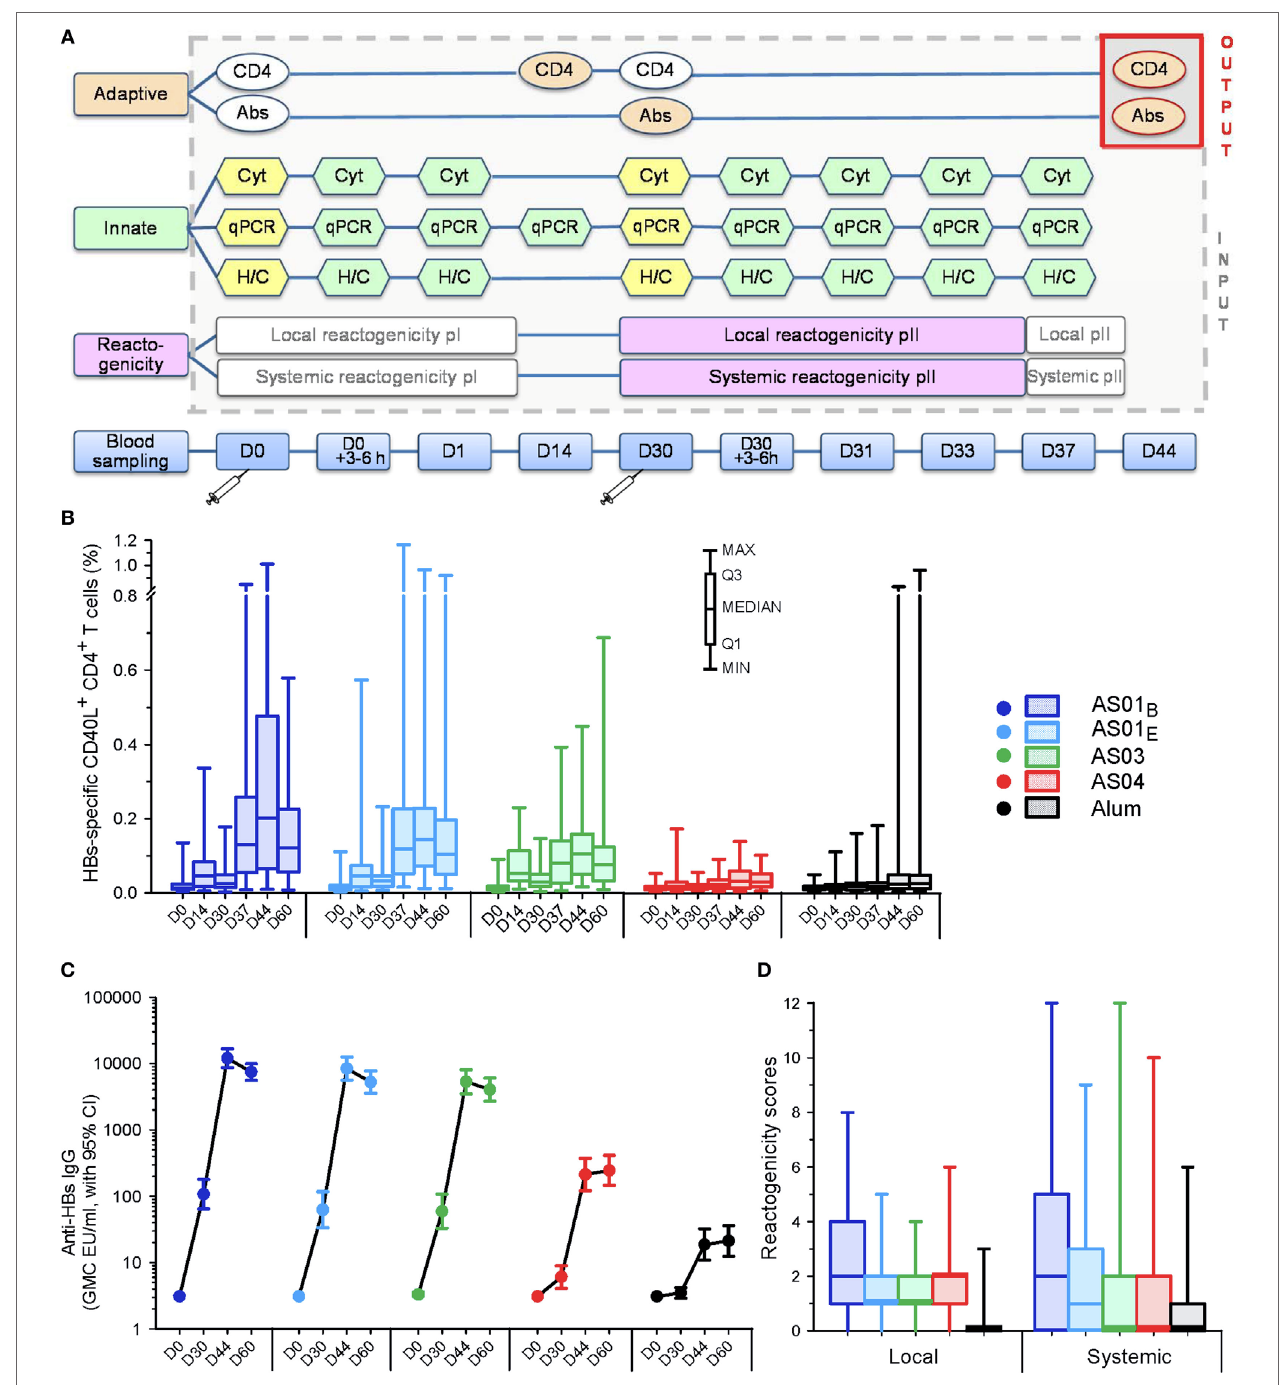
FiGUrE 1 | Multi-parametric analysis design and input parameters. (a) Study design schematic. Blood collection time-points for innate and adaptive immune response measurements and reactogenicity recordings are presented after the first and second vaccination (pI and pII, respectively) of hepatitis B surface antigen (HBsAg) adjuvanted with AS01 B , AS01 E , AS03 A , AS04, or aluminum salt (“Alum”). Adaptive responses pII (“output”) expressed as frequencies of HBsAg-specific CD40L + CD4 + T cells (CD4) or concentrations of HBs-specific antibodies (Abs) were modeled as a function of the innate immune responses pI or pII and reactogenicity pII (“input”). Innate parameters included cytokine/chemokine concentrations in serum (Cyt), gene expression assessed by qPCR in whole blood, and hematology and C-reactive protein measurements (H/C). Innate responses were expressed as fold-changes from baseline values (represented by the yellow shapes). White shapes represent values that were measured/recorded but not included in the multi-parametric analyses. Syringes indicate time-points of vaccination at days 0 and 30. Panels (b–D) represent the HBs-specific CD40L + CD4 + T-cell responses and anti-HBs antibody responses ( N = 286) through D60, and the local and systemic reactogenicity scores ( N = 291) for the pooled time-points of the reporting period after the second vaccination, respectively. GMC, geometric mean concentration. CI, confidence